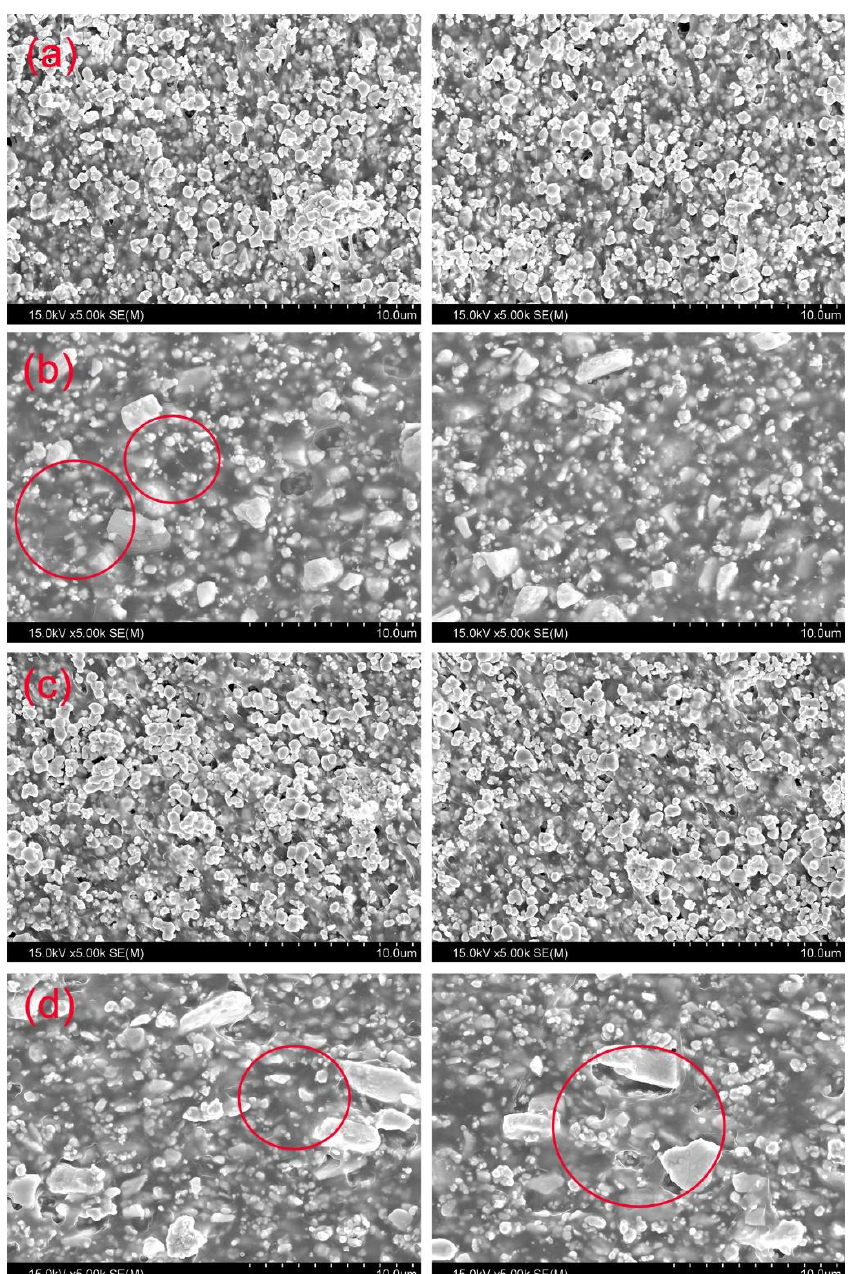
Figure 5. A visual evaluation of tungsten particle dispersion based on the conditions of the injection molding machine. ( a ) Particle distribution of the shield produced using a pre-mixing process by adding approximately 100 g of tungsten per hour, ( b ) Particle distribution of the shield produced by injecting 50% of the total volume of tungsten at approximately 230 g per hour (Red circles indicate voids caused by non-uniform particle distribution), ( c ) Particle distribution of the shield with improved mixing strength by increasing the screw rotational speed (350 rpm) and reducing the mixing time, ( d ) Particle distribution of the shield with reduced mixing strength by lowering the screw speed (50 rpm) and increasing the mixing time (Red circles indicate voids due to polymer voids). A panel of dimensions 0.5 m × 0.5 m × 2 mm (102 ± 0.01 g) that could be used as a The injection volume of tungsten and the rotational speed of the screw affect the material for a radiation shielding barrier was finally manufactured, as shown in Figure 6. particle residence time distribution and negatively affect the strength of the injection- molded product [34]. As shown in Figure 5c, if the maximum volume of tungsten is injected and the screw speed is increased to improve the affinity of the polymer, the